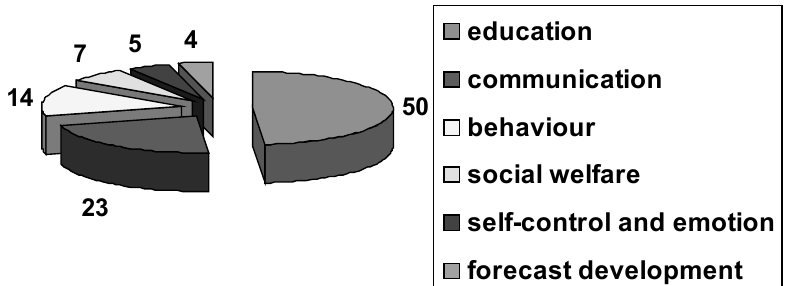
Fig. 1. Distribution of teachers answers as for the main problems of autistic children. Source:Own chart.